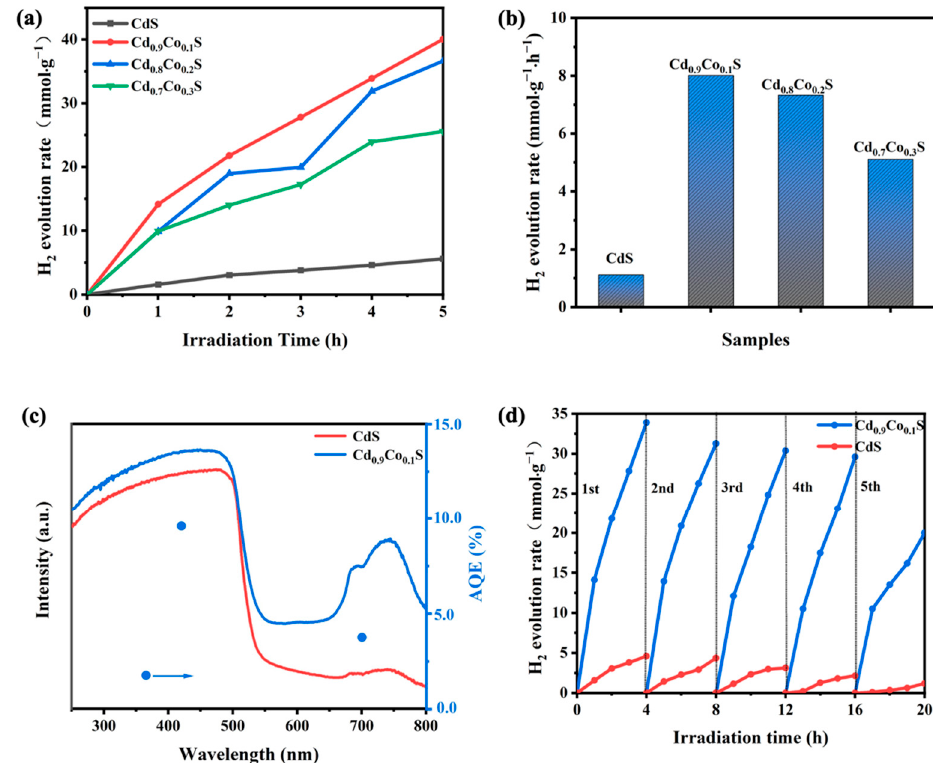
Figure 4. Time-dependent photocatalytic H 2 evolution ( a ) and H 2 evolution rates for all samples ( b ). Apparent quantum efficiency (AQE) and the UV–vis absorption spectrum of Cd 0.9 Co 0.1 S NRs ( c ). The AQE equals twice the number of evolved H 2 molecules divided by the number of incident photons under light irradiation with specific wavelengths (365, 420, and 700 nm). Cyclic tests of photocatalytic H 2 evolution for pure CdS and Cd 0.9 Co 0.1 S ( d ).